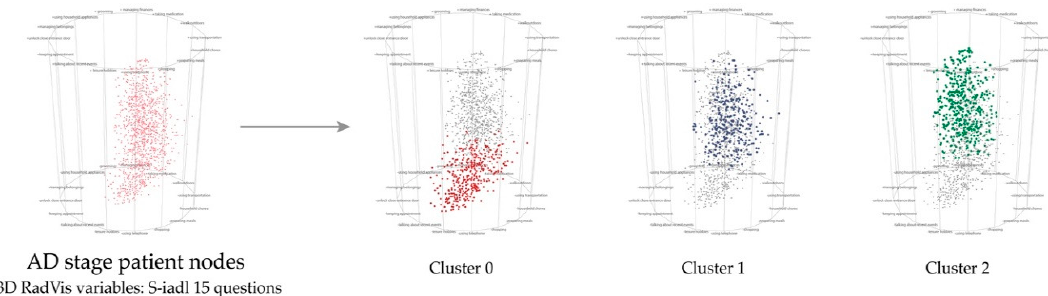
Figure 7. The result of segmenting patients on AD stage into 3 groups.